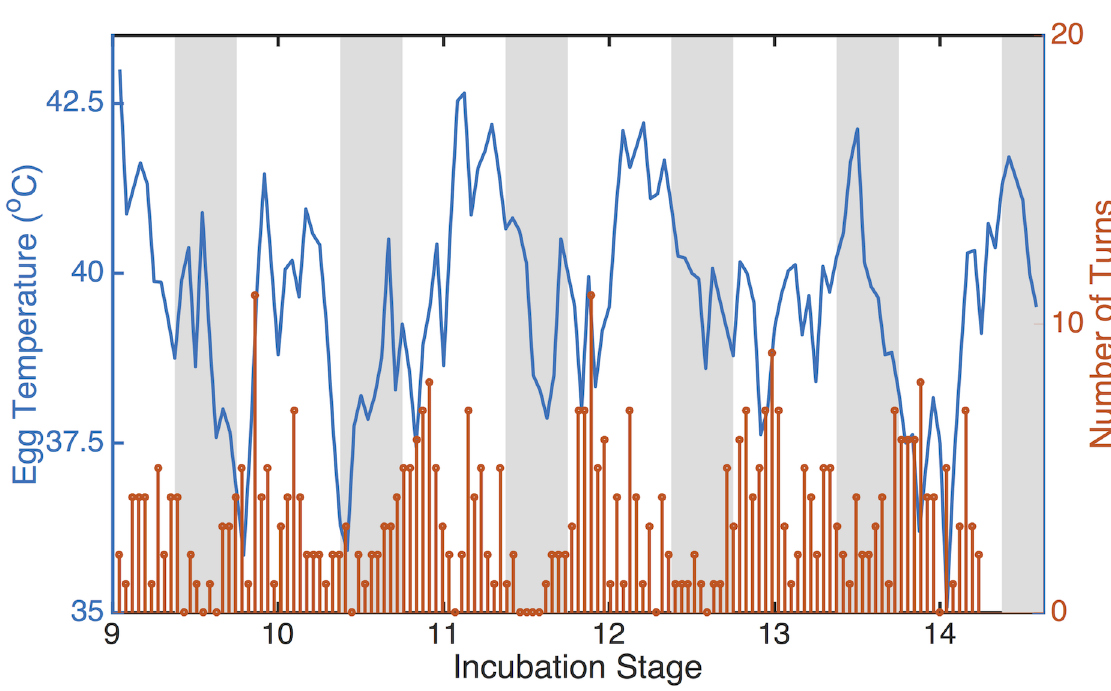
Fig 3. Five days of egg temperature and egg turn rate from a single tern nest. The blue line represents egg temperature, and the orange bars represent the number of egg turns in each hour. White areas indicate daytime, while gray areas indicate nighttime. temperature (daytime: 40.0 ± 2.5 ˚C, nighttime: 38.9 ± 2.4 ˚C) and egg THg concentrations